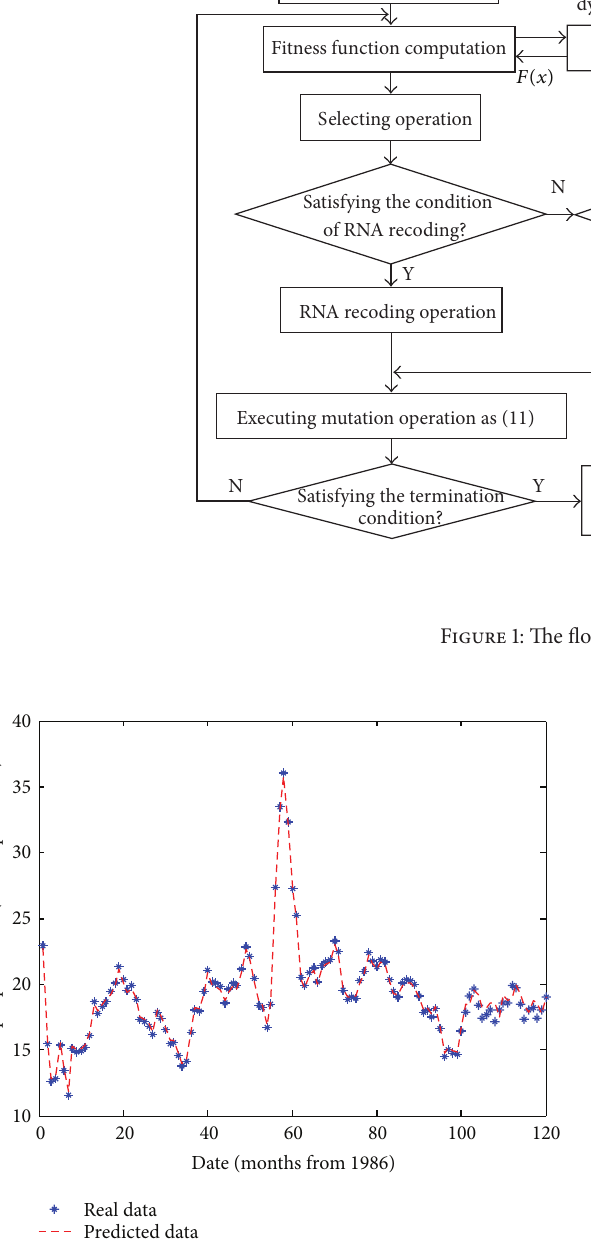
Figure 2: The prediction curve of HRGA- 𝜀 - 𝑆𝑉𝑅 .